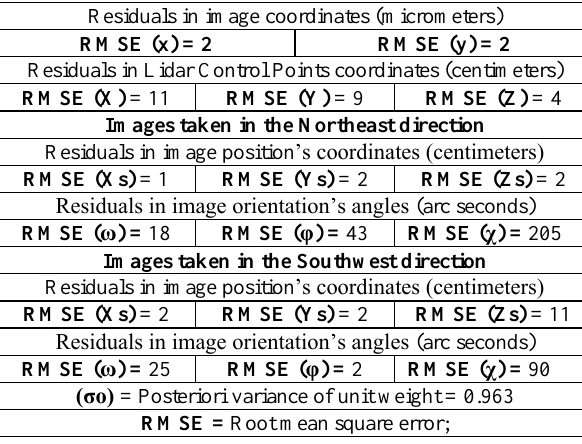
Table 1. Main results of the residuals analysis performed in